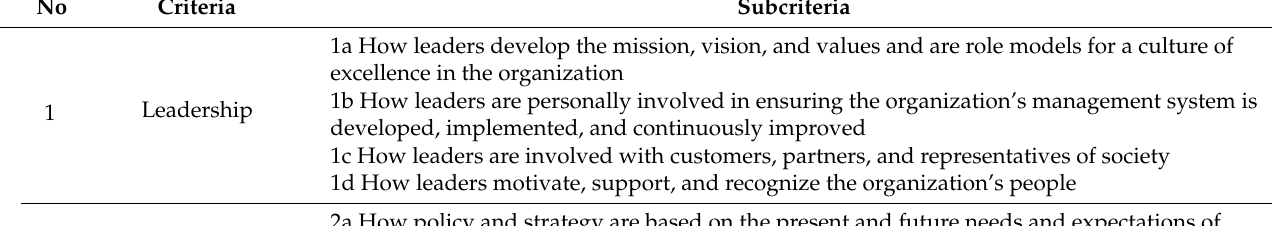
Table A1. EFQM Excellence Model criteria and sub-criteria.